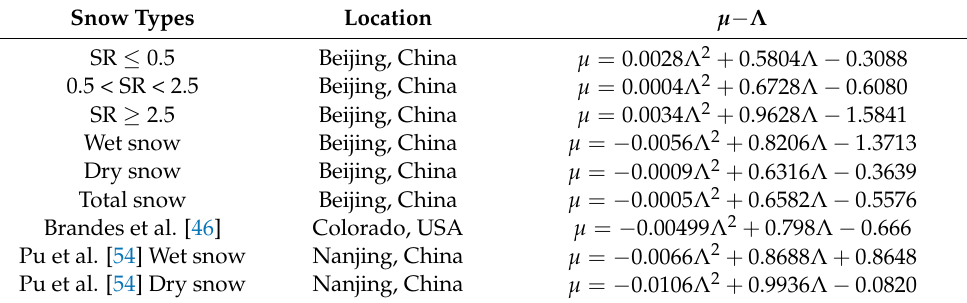
Figure 6. Scatterplot and binomial relationship fitting of 𝜇 and 𝛬 [46,54]. Table 3. The relationship of 𝜇 − 𝛬 for snow.